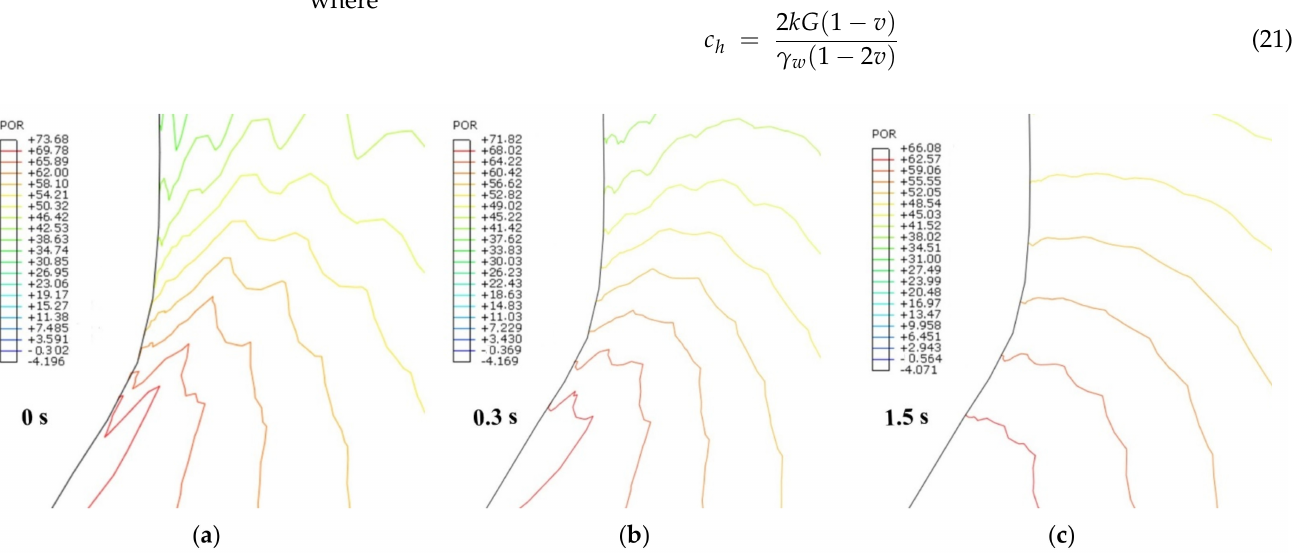
Figure 7. ∆ u contours after dissipation for 0 s, 0.3 s and 1.5 s in kaolin silty clays. ( a ) t = 0 s; ( b ) t = 0.3 s; ( c ) t = 1.5